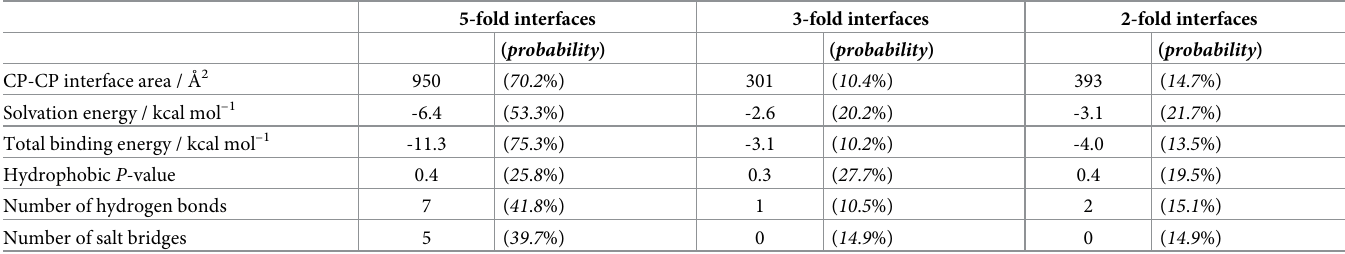
Table 2. Analysis of the FBNSV CP-CP interfaces.